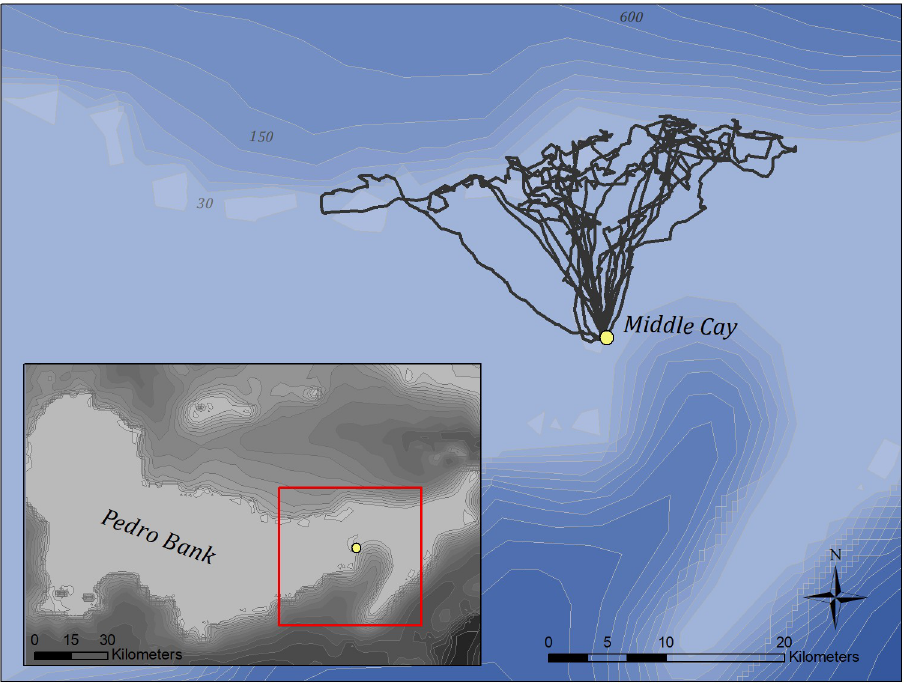
Fig 1. Complete foraging trips of GPS-equipped Masked Boobies from Middle Cay, Jamaica (yellow marker). Gray lines represent bathymetric gradients, with darker colors indicating an increase in depth. Numbers represent approximate